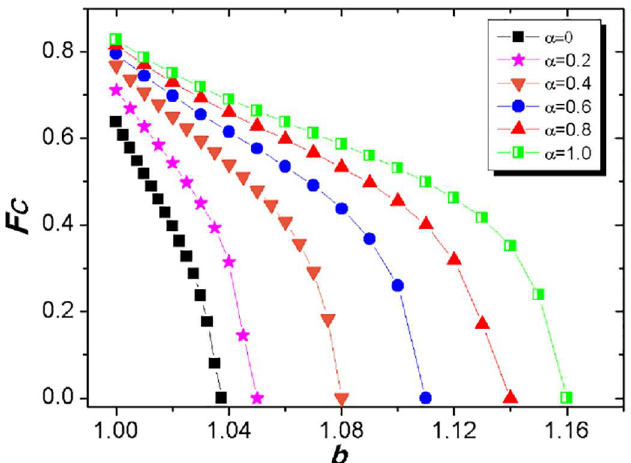
Fig 3. Fraction of cooperators ( F C ) at the stationary state as a function of temptation to defect ( b ). The system setup is assumed to be L = 200, MCS = 5 × 10 4 and κ = 0.1, and the tunableparameter α is set to be 0, 0.2, 0.4, 0.6, 0.8 and 1.0, respectively.